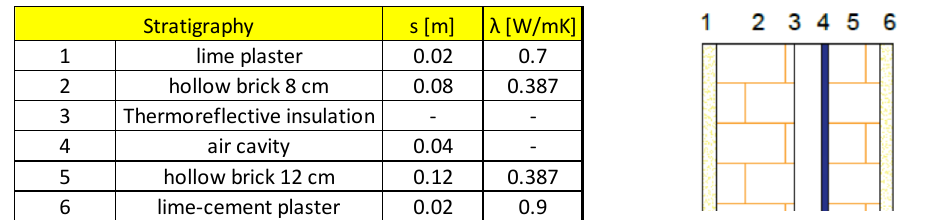
Figure A6. Wall type 3.1: transmittance check for the three main Italian climatic zones. In blue are the heat-reflective materials which respect all the limits.